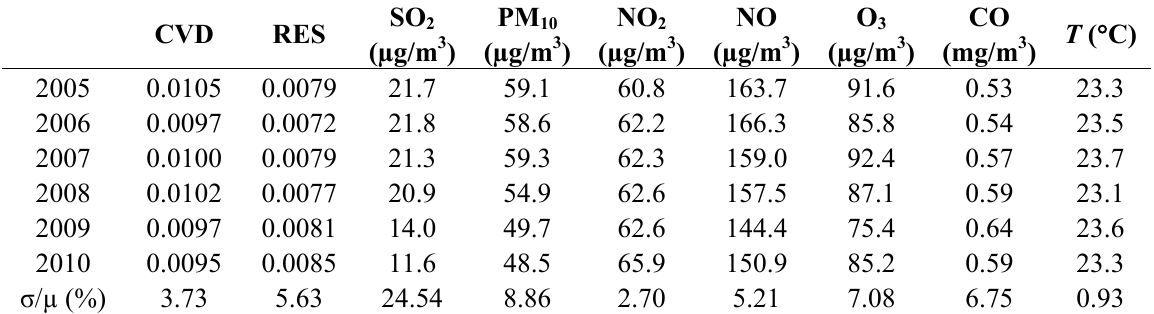
Table 1. Annual statistics of elderly mortality, major pollutant concentration and temperature of Hong